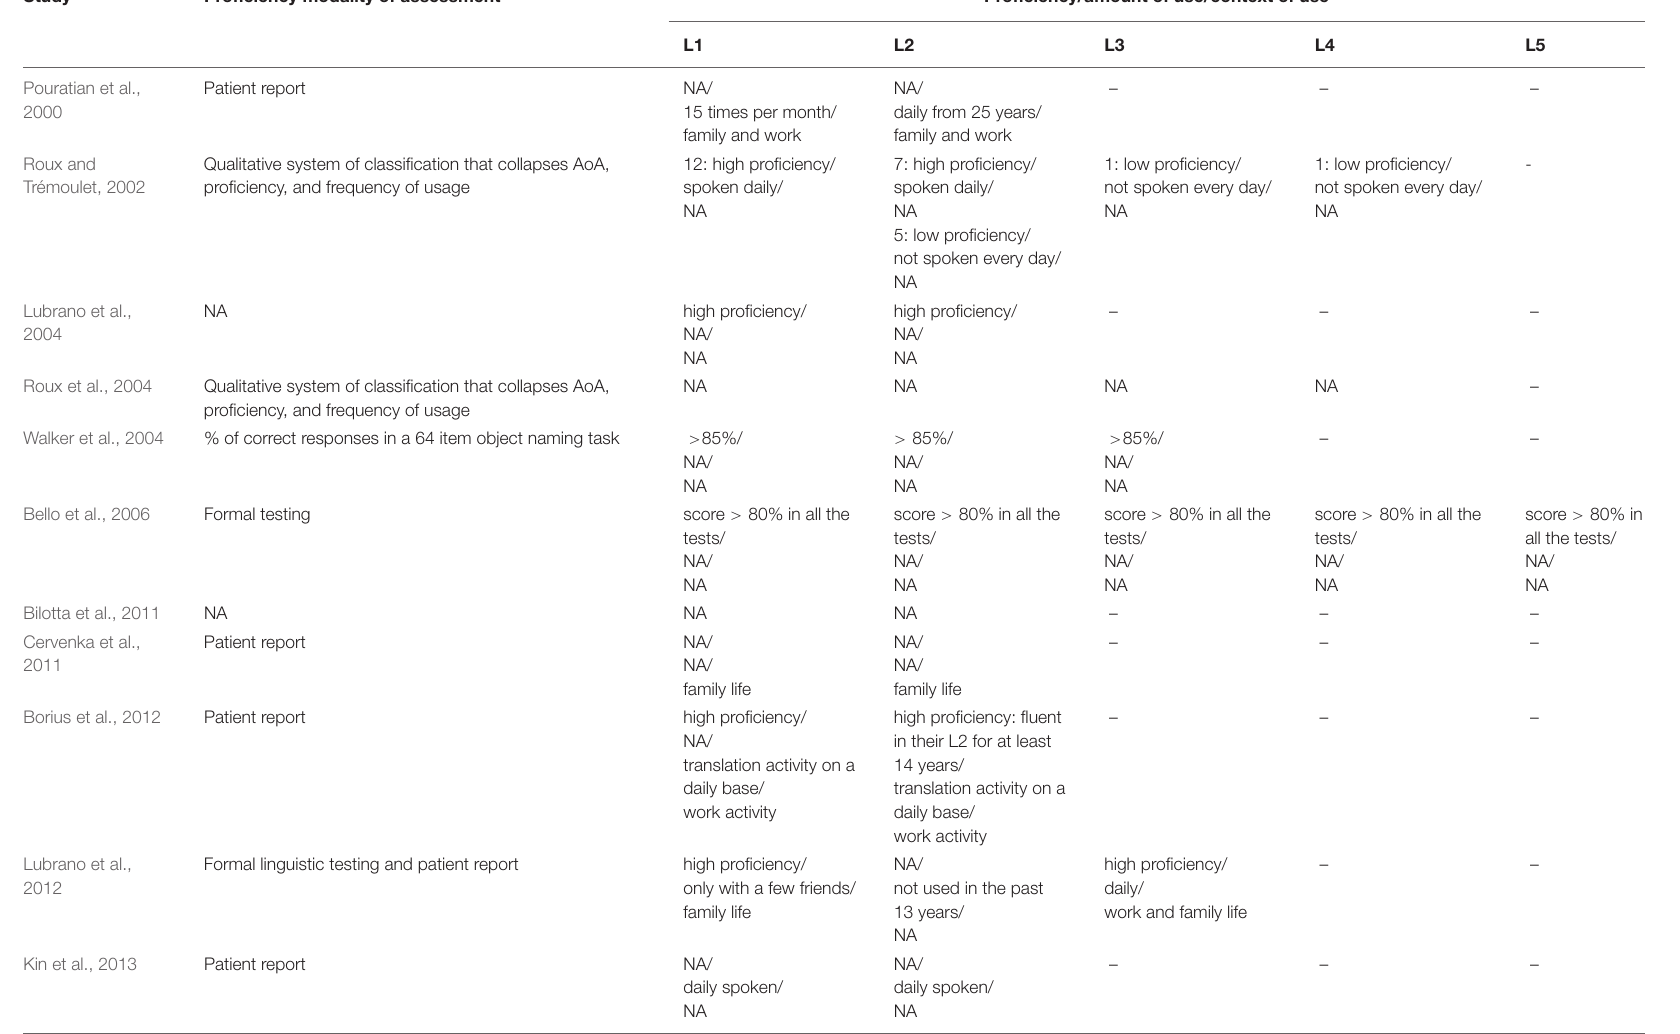
TABLE 4 | Language proficiency.